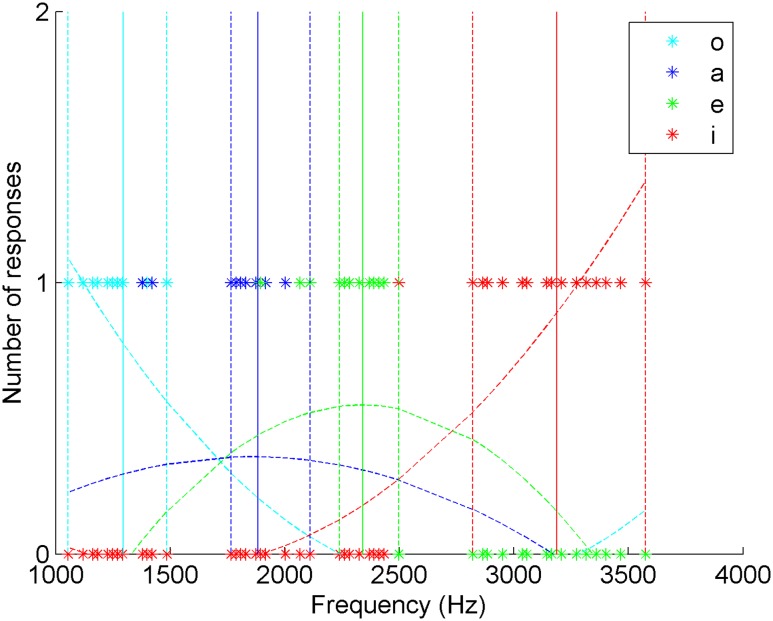
Distribution of the answers of a native and fluent La Gomera whistler of whistled Spanish and estimated curves of whistler’s answers as a function of the frequencies of the Spanish whistled vowels. For each vowel the plain vertical line represents the mean frequency value of the played vowels and the dotted lines represent the extreme frequency values of the corresponding interval.